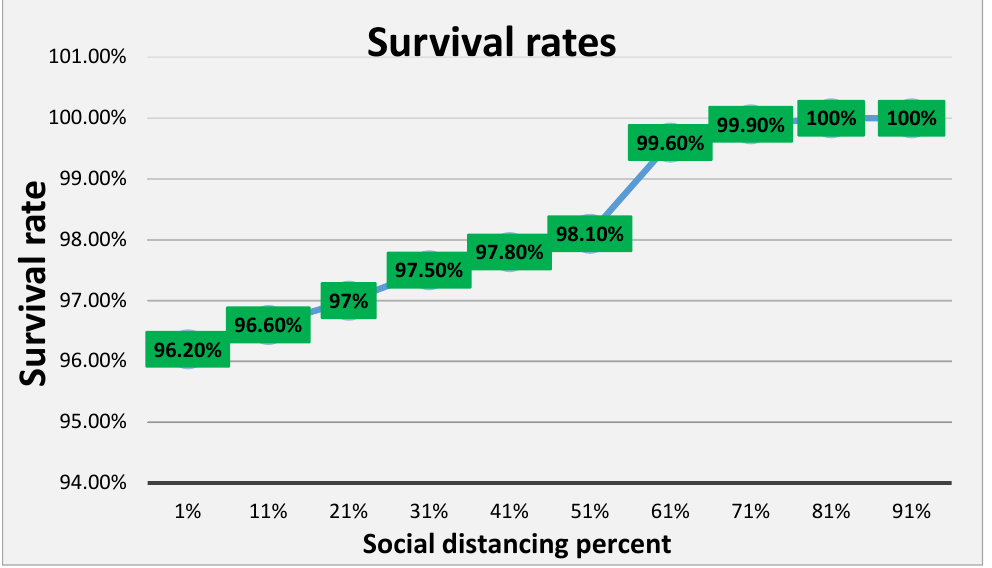
Figure 20. Survival rate versus percentage of social distancing.